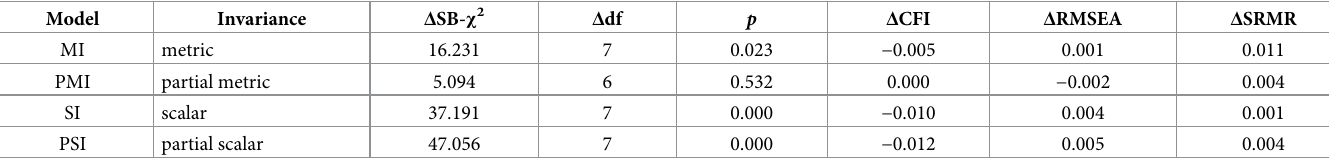
Table 5. Model comparisons for invariance